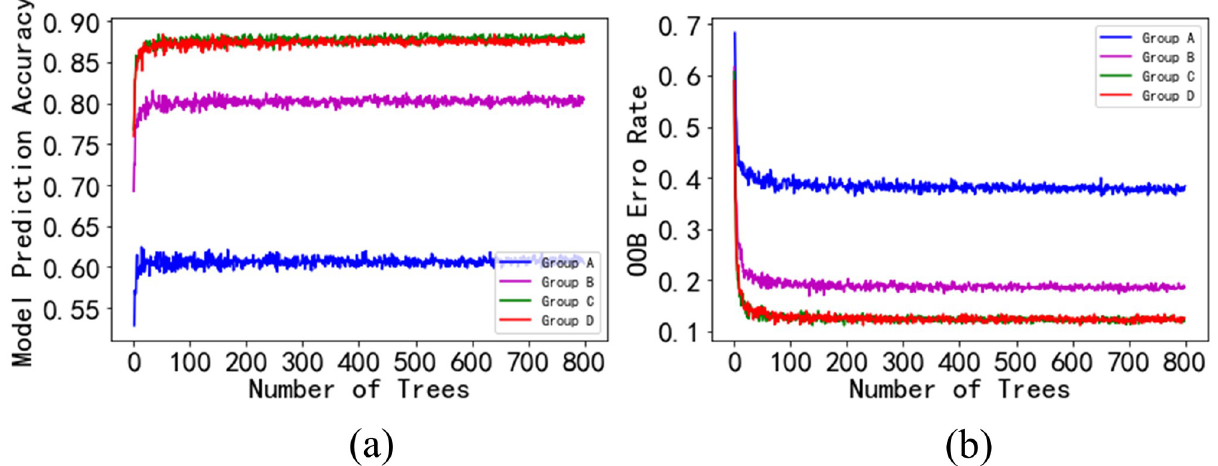
Fig 5. Influences of the different feature group inputs on the classification results of the random forest model: a) relationship between the model prediction accuracy and the number of trees; and b) relationship between the out-of-bag error and the number of trees.